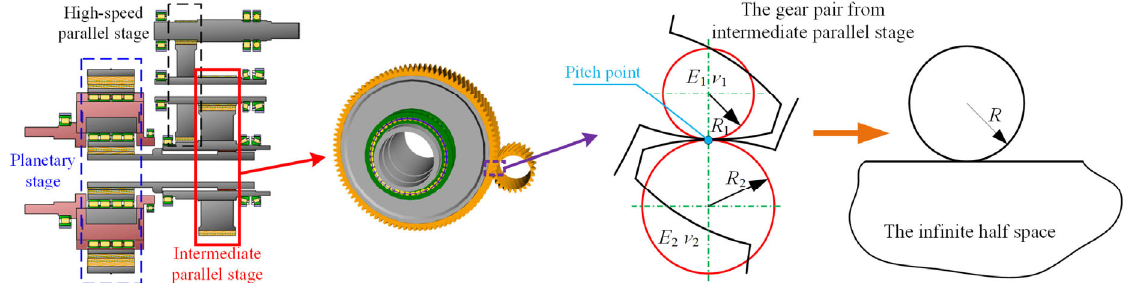
Fig. 3 Description of the gear contact